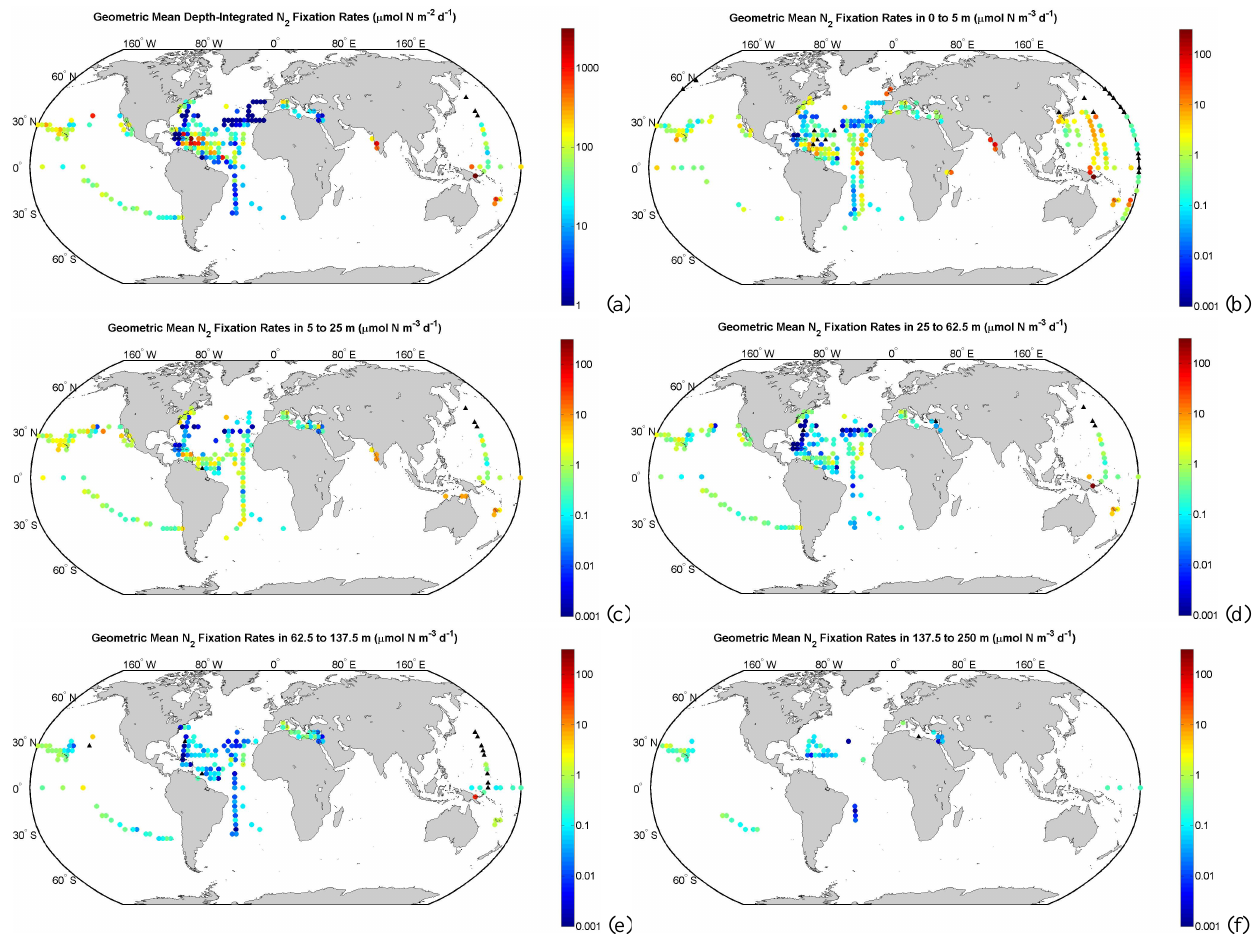
Figure 6. (a) Geometric mean depth-integrated N 2 fixation rates binned on 3 ◦ × 3 ◦ grid. Also geometric mean N 2 fixation rates on 3 ◦ × 3 ◦ grid for 5 vertical layers of (b) 0–5m, (c) 5–25m, (d) 25–62.5m, (e) 62.5–137.5m and (f) 137.5–250m. The color bar is in logarithmic scale. Zero values are marked with black